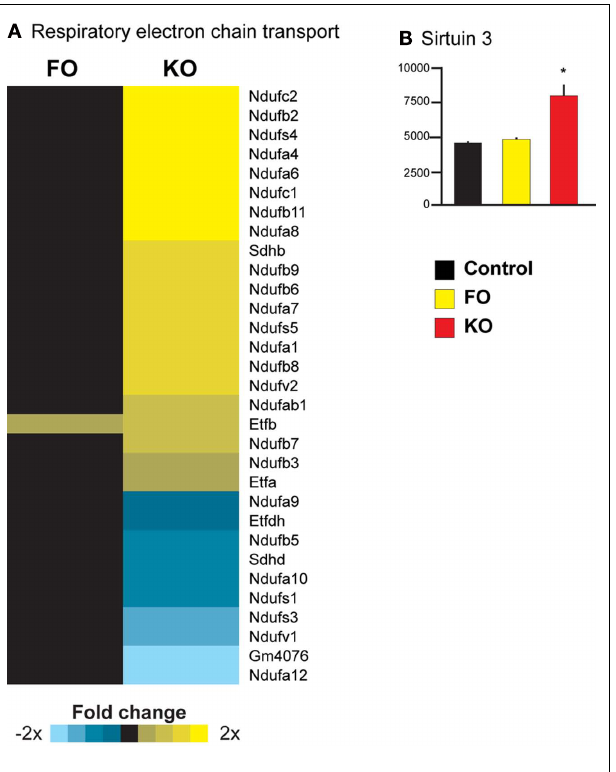
FIGURE 5 | Upregulation of mitochondrial energy metabolism in liver of mice consuming KO. Pathway analysis revealed a significant upregulation of the pathway “Respiratory electron transport” in the KO group (A) . A transcriptional regulator of nuclear genes regulating mitochondrial energy metabolism, Sirt3 , was also upregulated by KO (B)